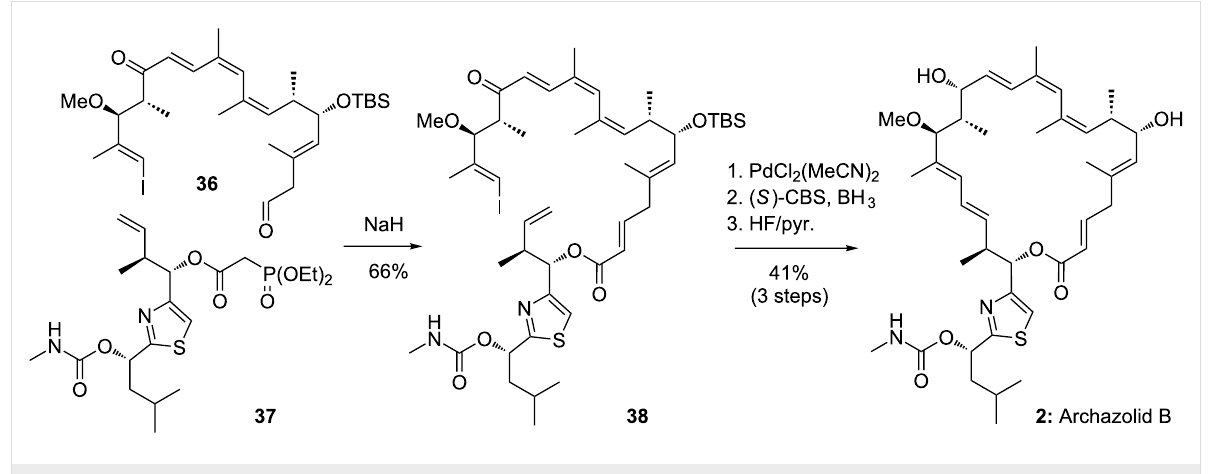
Scheme 7: Synthesis of archazolid B ( 2 ) by a ring closing Heck reaction of 38